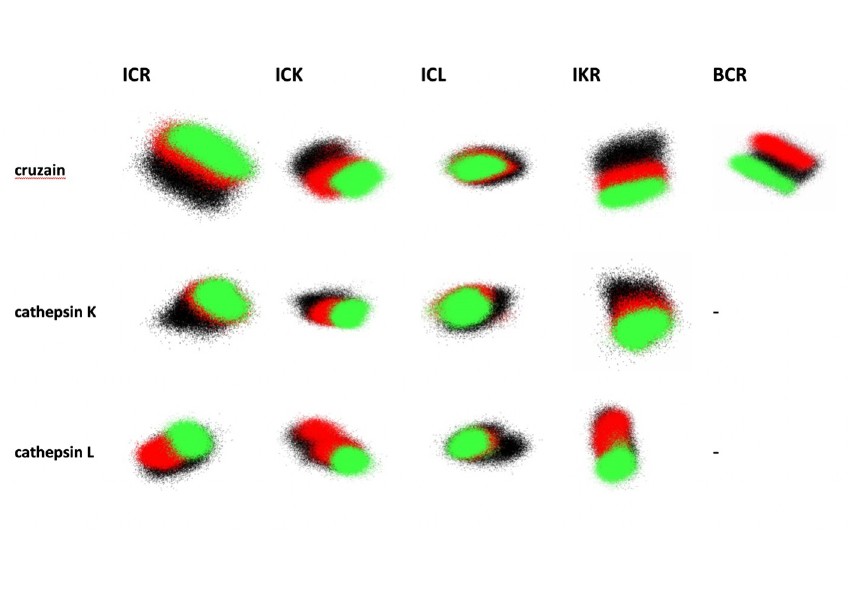
Fig 2. Projections onto the first two principal components of cruzain (first row), cathepsin K (second row) and cathepsin L (third row) simulations in their apo form and complexed with noncovalent and covalent forms (black, red and green dots, respectively) of ligands ICR, ICK, ICL IKR and BCR. Each panel is at the same scale (40 Å ngstroms in both X and